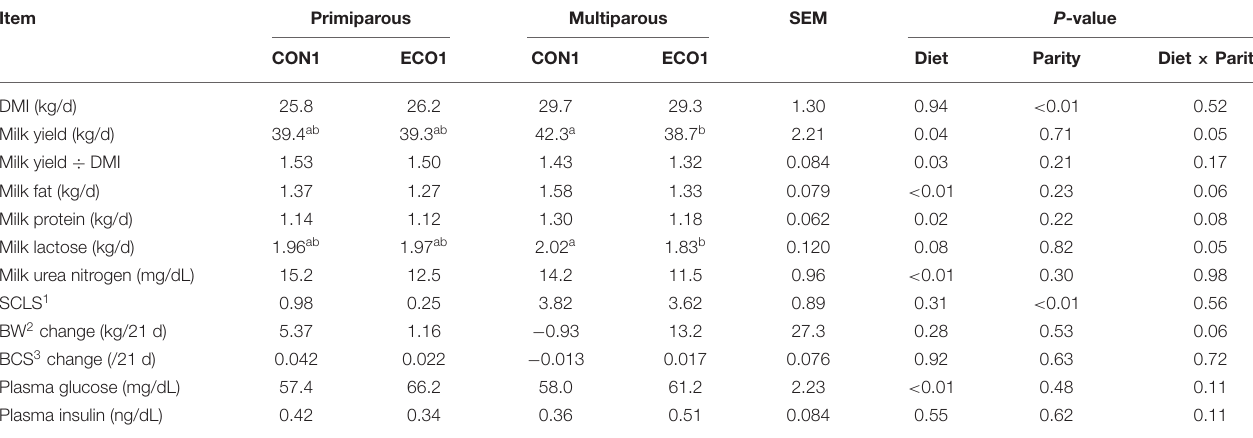
TABLE 6 | Performance and blood plasma metabolites of mid-lactation cows fed a conventional lactation diet or a by-product-based diet (Experiment 1).